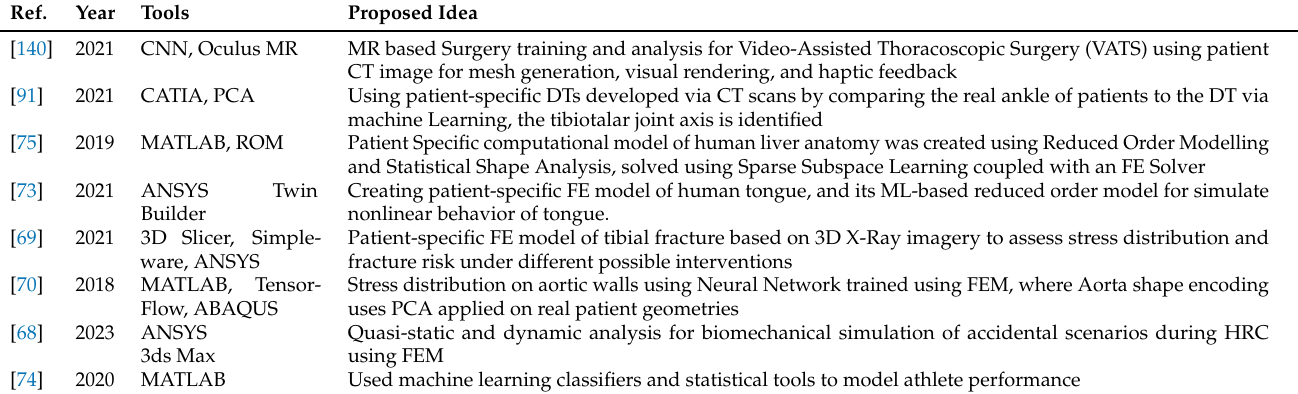
Table 8. Applications in Rehab, Well-being and Health